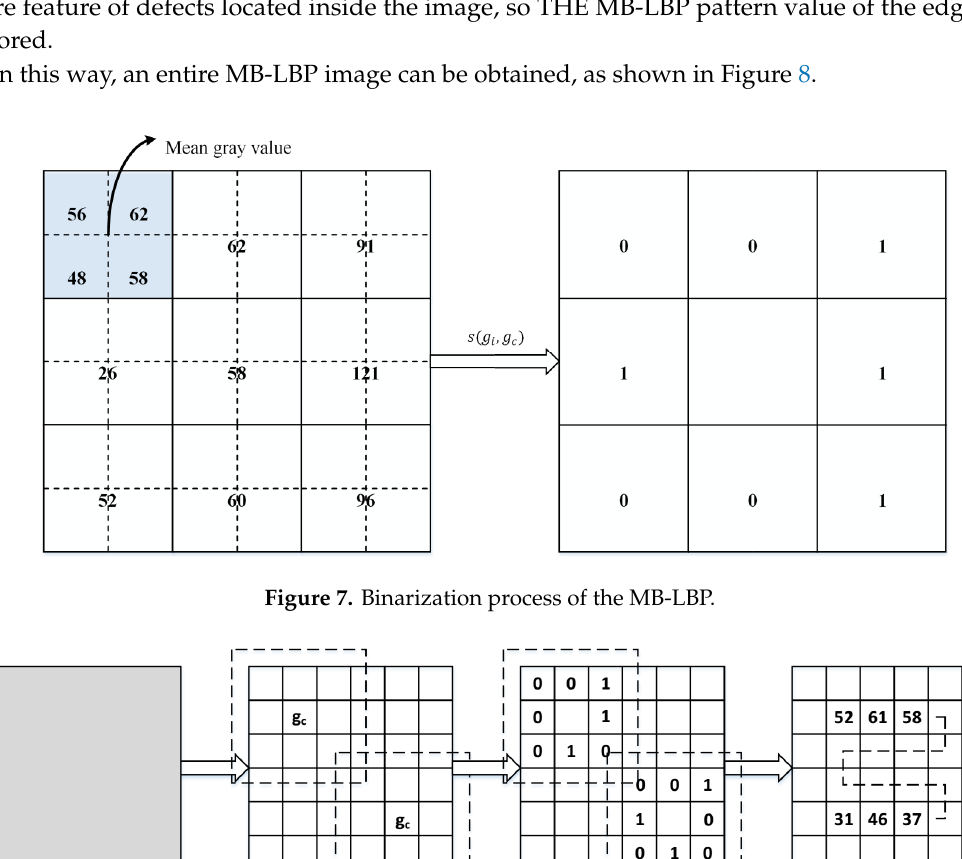
Figure 8. Obtain the MB-LBP pattern value of the entire image.